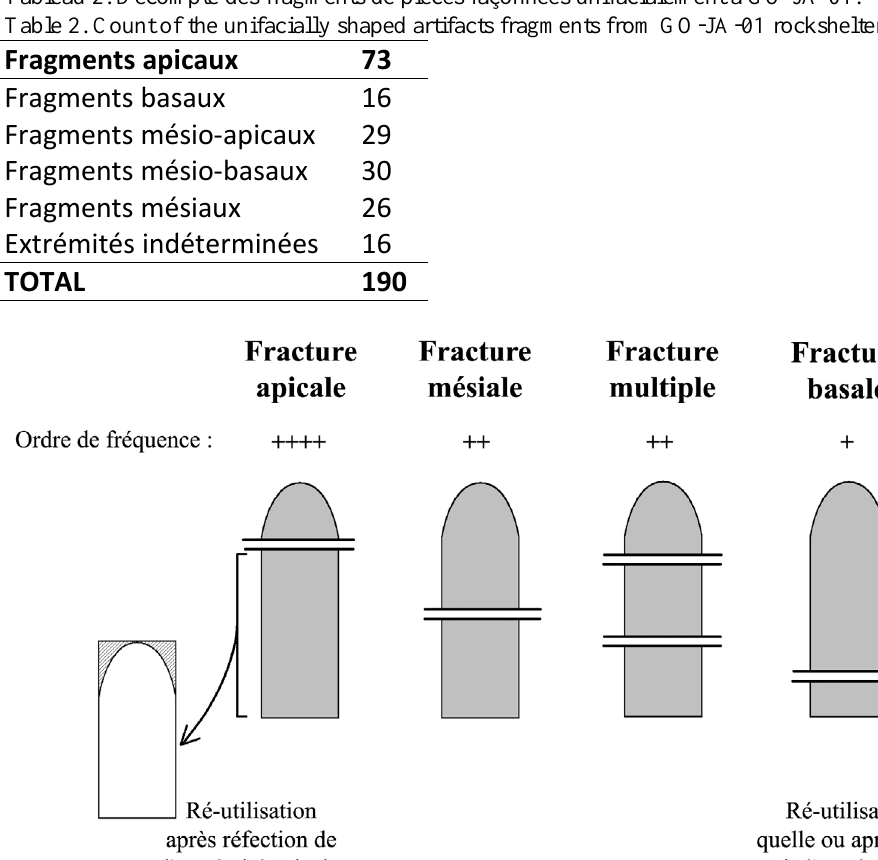
Tableau 2. Décompte des fragments de pièces façonnées unifacialement à GO-JA-01. Table 2. Count of the unifacially shaped artifacts fragments from GO-JA-01 rockshelter.